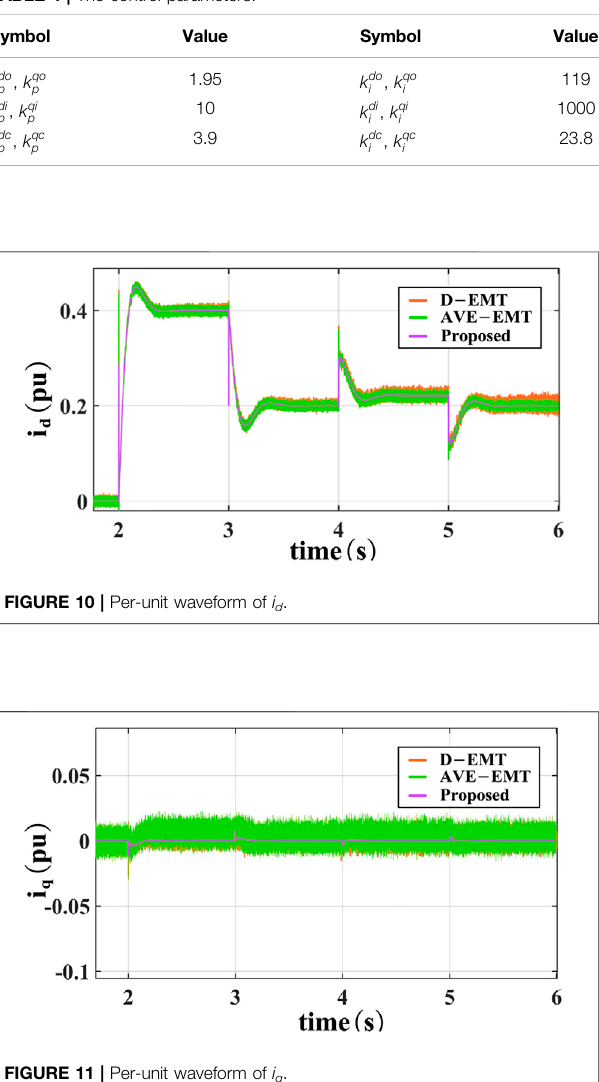
FIGURE 11 | Per-unit waveform of i q .